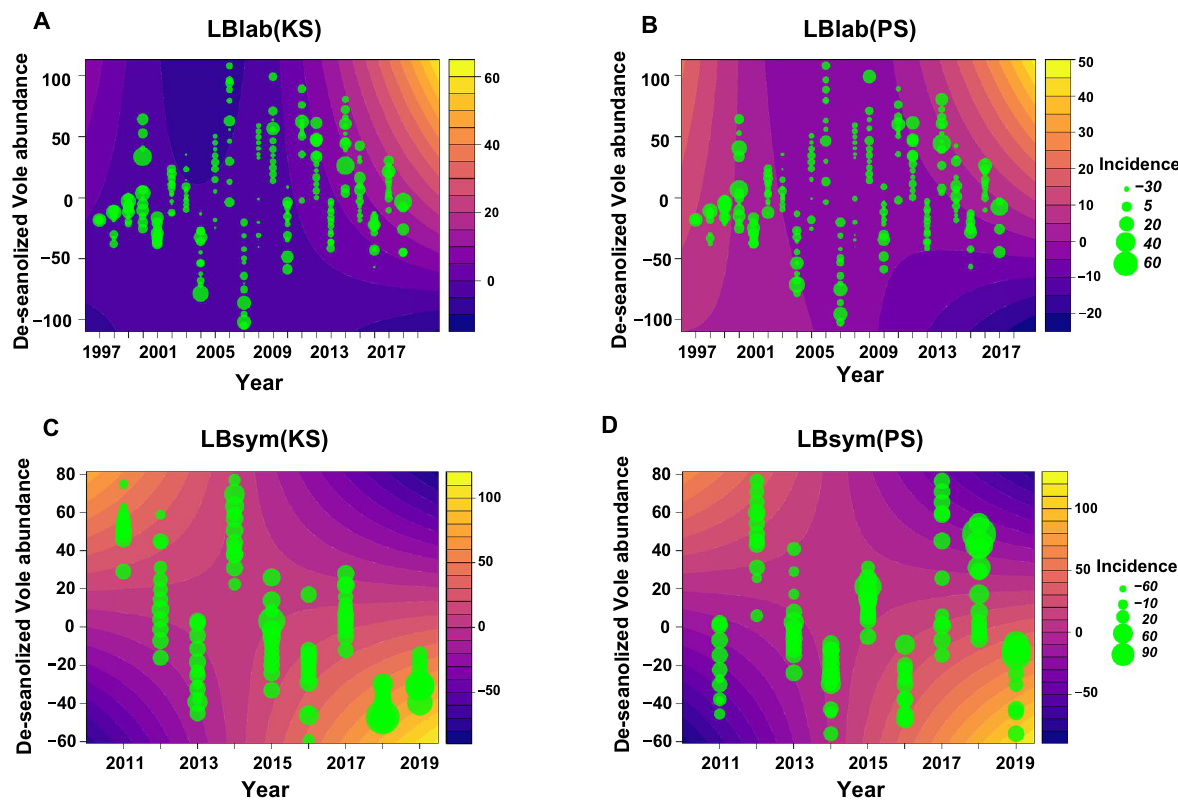
Figure 2. Contour plots showing the regression surfaces drawn on the grounds of fixed effects of linear mixed-effect models explaining laboratory-diagnosed LB ( A , B ) and symptom-diagnosed LB ( C , D ) incidence in relation to bank vole abundance 12 ( A , B ) and 10 ( C , D ) months earlier in two hospital districts (PS: Northern Savo, KS: Central Finland). The circles depict the data points, circle size increasing with increasing incidence of LB. Both LB incidence and bank vole abundance data were de-seasonalized by subtracting month-specific mean from each observation. The coefficients used in drawing the regression surfaces are presented in Tables 1 and 2. De-seasonalized bank vole abundance 24 months earlier was set to the mean of that variable for the derivation of the regression surfaces (bank vole abundance 24 months earlier does not affect the shape of the regression surface, only the elevation of it). Figure created by using R version 3.5.3 58